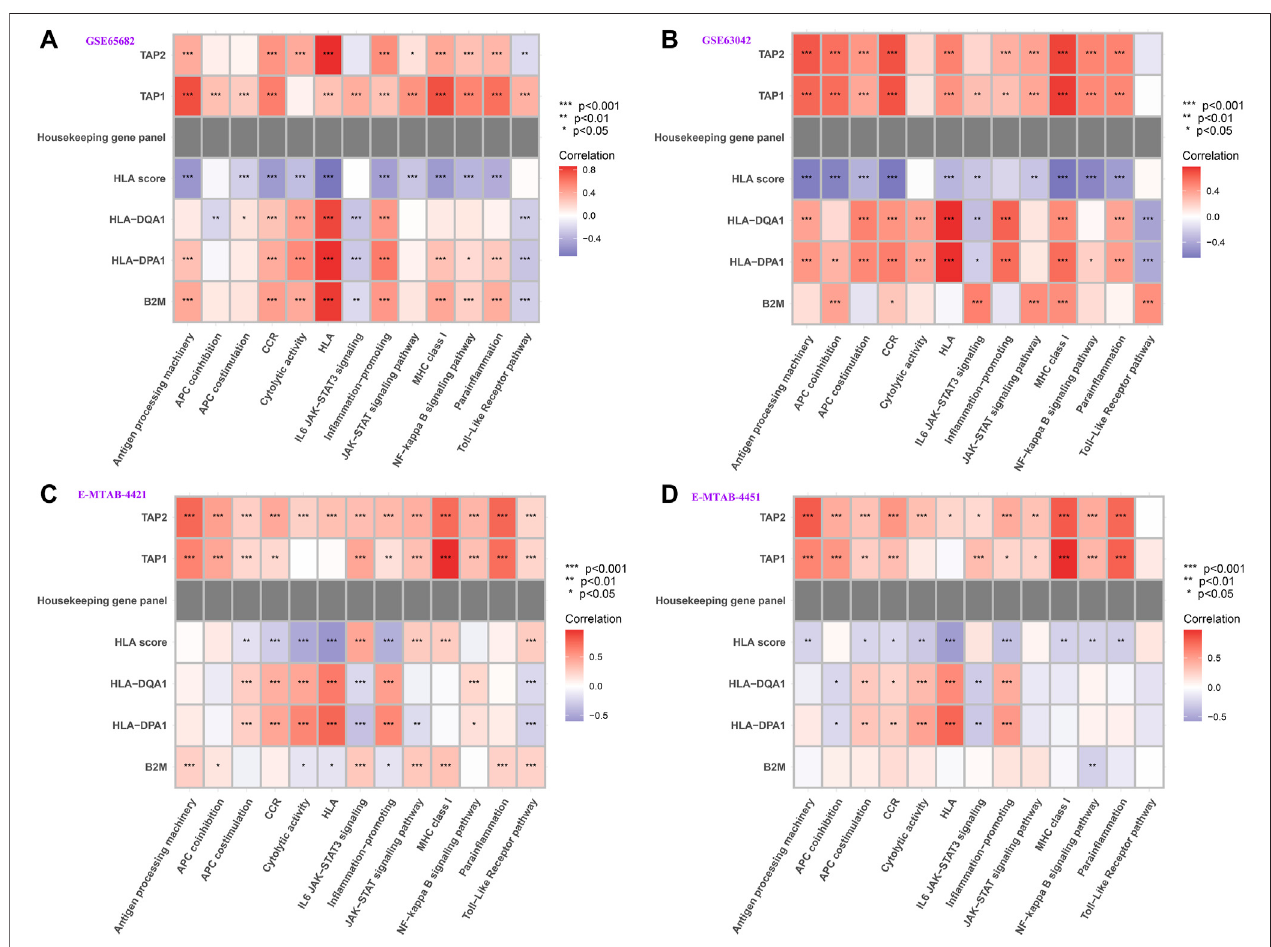
FIGURE10| Correlation betweenHLAclassi fi er/genesandimmune-relatedpathwaysinmultipletranscriptomedatasets. (A) GSE65682datasets. (B) GSE63042 datasets. (C) E-MTAB-4421 datasets. (D) E-MTAB-4451 datasets.